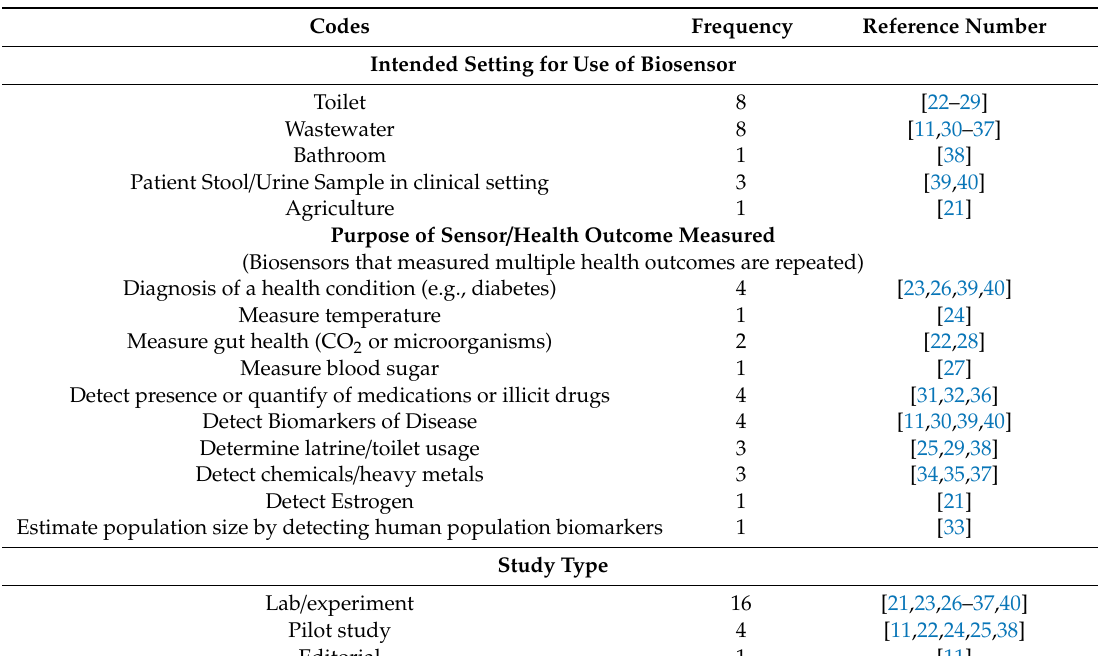
Figure 1. Study Selection. Table 2. Study